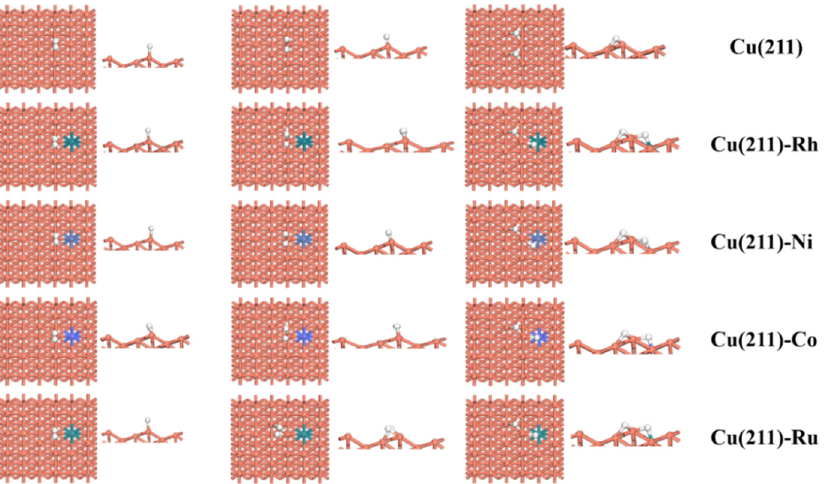
Figure 2. The stable adsorption configurations of CO 2 , COOH, HCOO, and H 2 on pure and transition-metal-doped Cu(211)-M (M = Rh, Ni, Co, and Ru) surfaces.